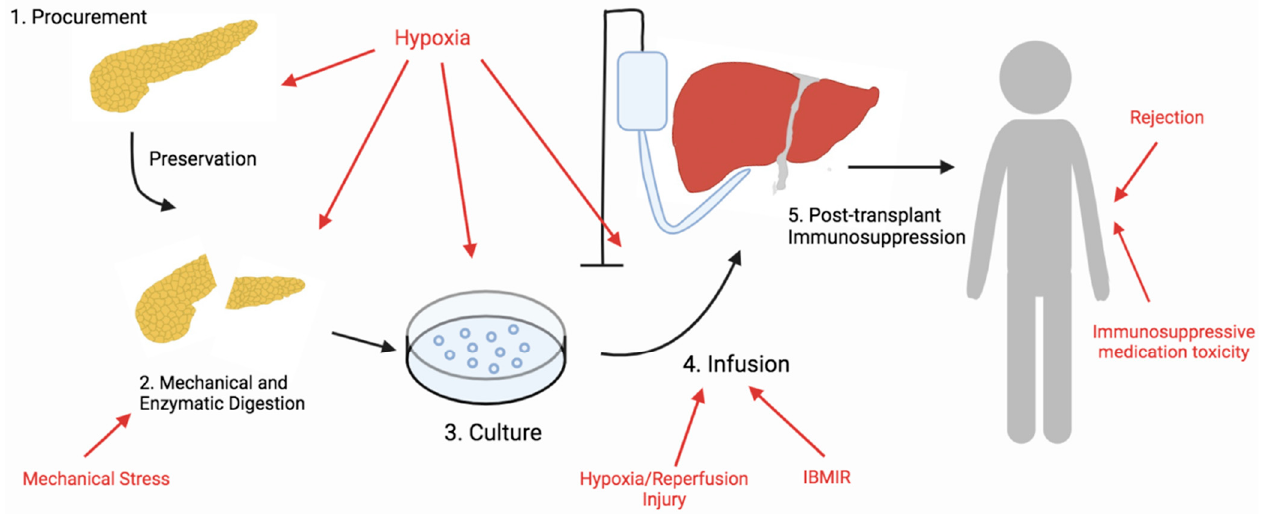
Figure 1. Overview of the steps of islet cell transplantation. Islet cells are exposed to a plethora of stressors that lead to oxidative stress during the islet transplantation process. Sources of oxidative stress during each step are indicated by the red color.